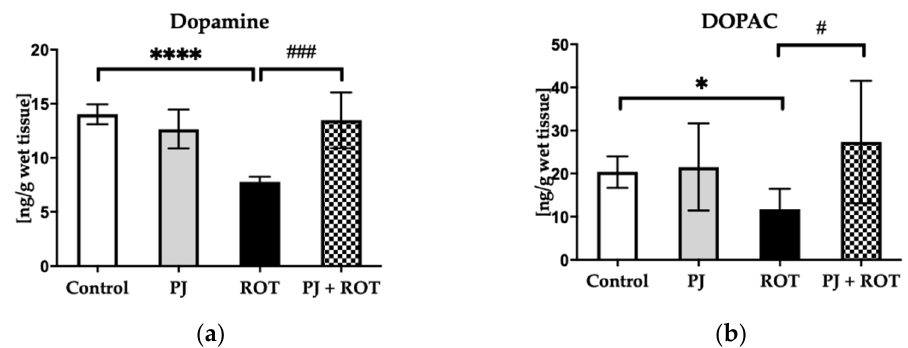
Figure 4. Effect of pomegranate juice treatment (PJ) on: ( a ) dopamine (DA); ( b ) DOPAC levels in the midbrains of rotenone (ROT)-injected rats. Data are presented as mean values ± SEM of eight rats per group and analyzed using one-way analysis of variance (ANOVA) followed by Fisher’s LSD test. **** p < 0.0001 vs. Control; * p < 0.05 vs. Control, ### p < 0.001 vs. ROT; # p < 0.05 vs. ROT.